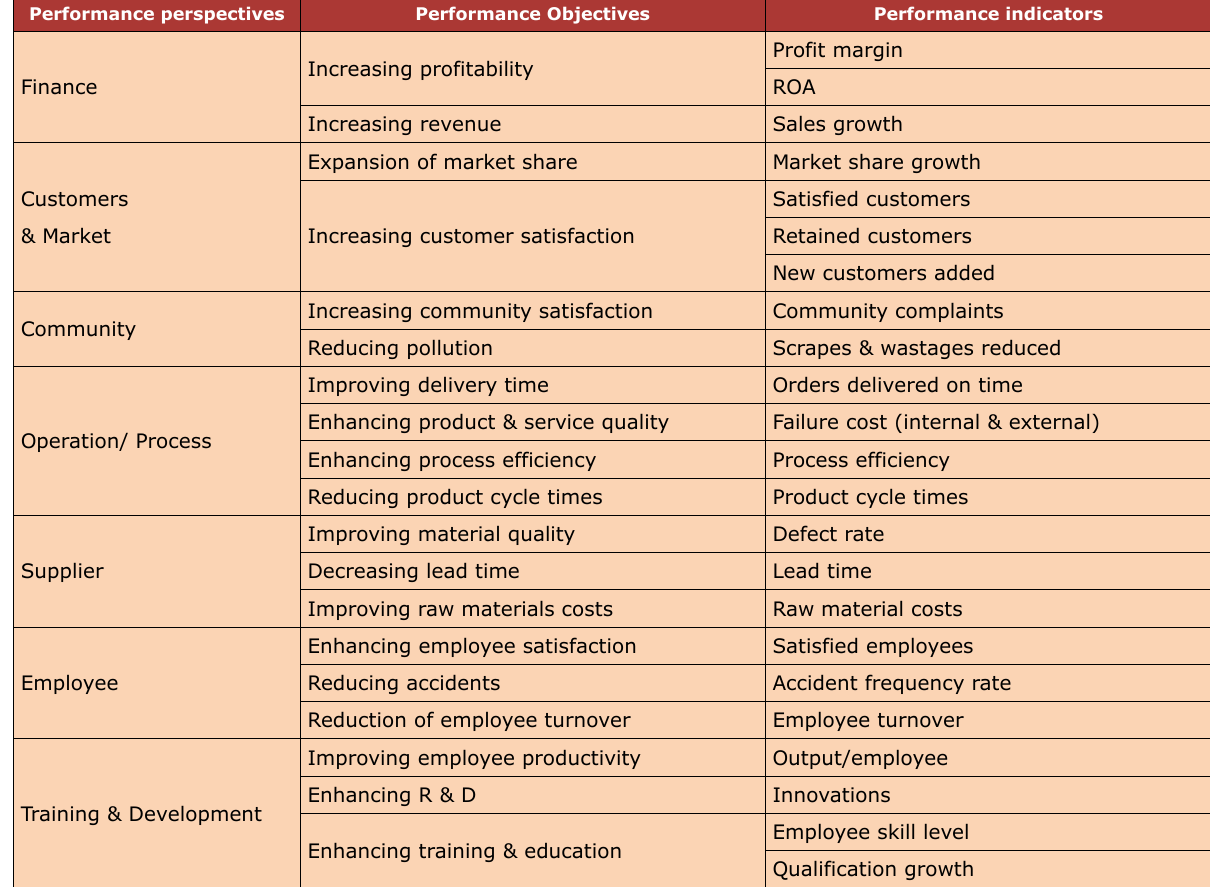
Table 10. Performance Measurement